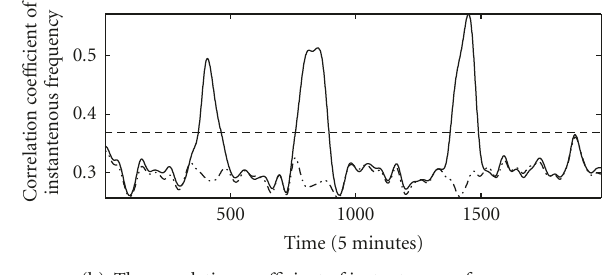
Figure 13: The detection results of nonperiodic DDoS attacks.